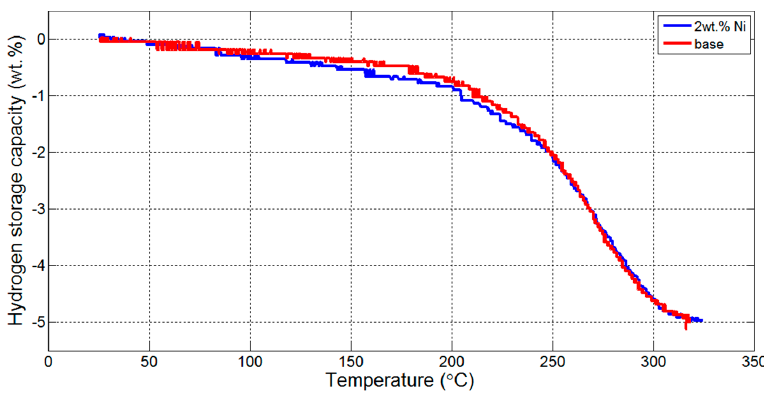
Figure 5. Ramping kinetics of 2LiNH 2 -nanoMgH 2 and 2LiNH 2 -nanoMgH 2 + 2 wt. % Ni.